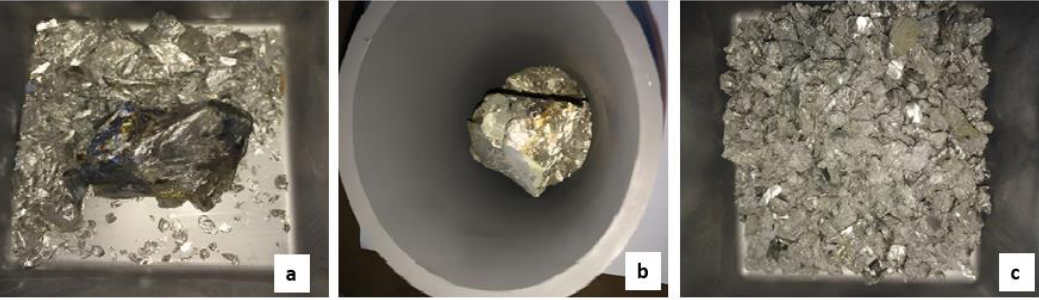
Figure 7. ( a ) initial NbNi sample, ( b ) NbNi alloy in the graphite crucible and ( c ) Ti “sponge”. After the VIM process, the Ni 33 Ti 39 Nb 28 ingot, with a diameter of 80 mm, was removed from the crucible. Figure 8 shows the ingot before and after cutting; its final measured composition is reported in Table 2.